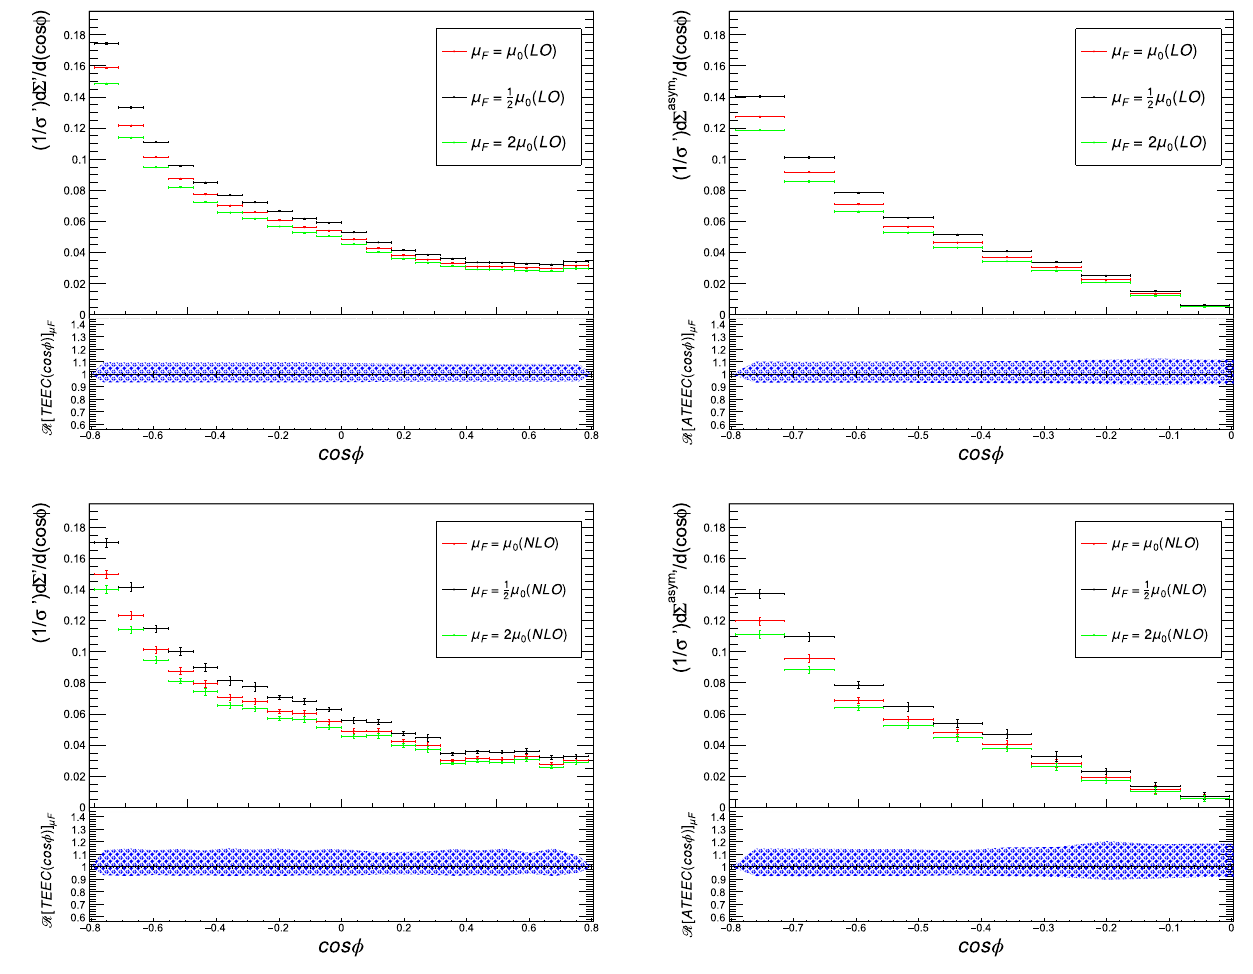
inal scale defined in the text, calculated with the MMHT14 PDFs for the low- Q 2 : 5 . 5GeV 2 < Q 2 < 80GeV 2 at HERA. The correspond- ing μ F -dependence is also shown in terms of R [ TEEC ( cos φ) ] μ and F R [ ATEEC ( cos φ) ] μ , defined in Eq. F